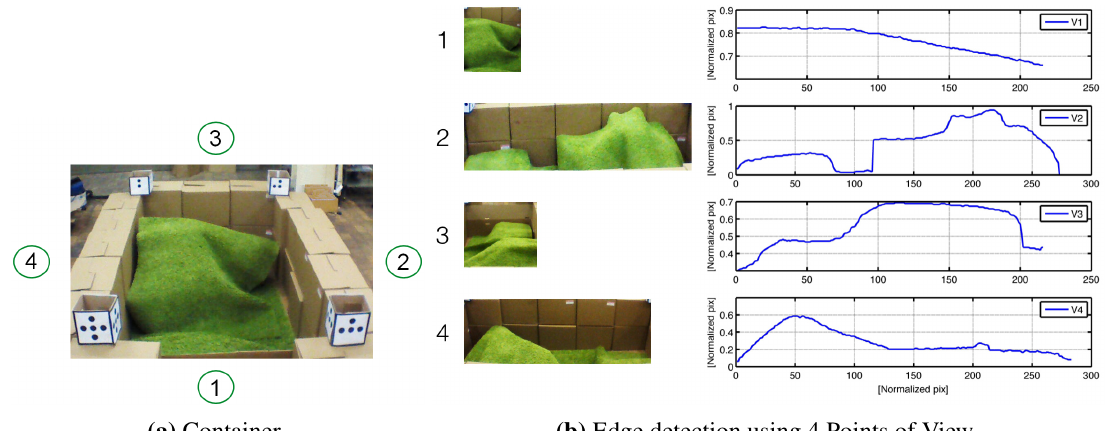
Figure 14. Example of ( a ) material profile in the container and ( b ) the information extracted using the edge detection algorithm considering four points of view